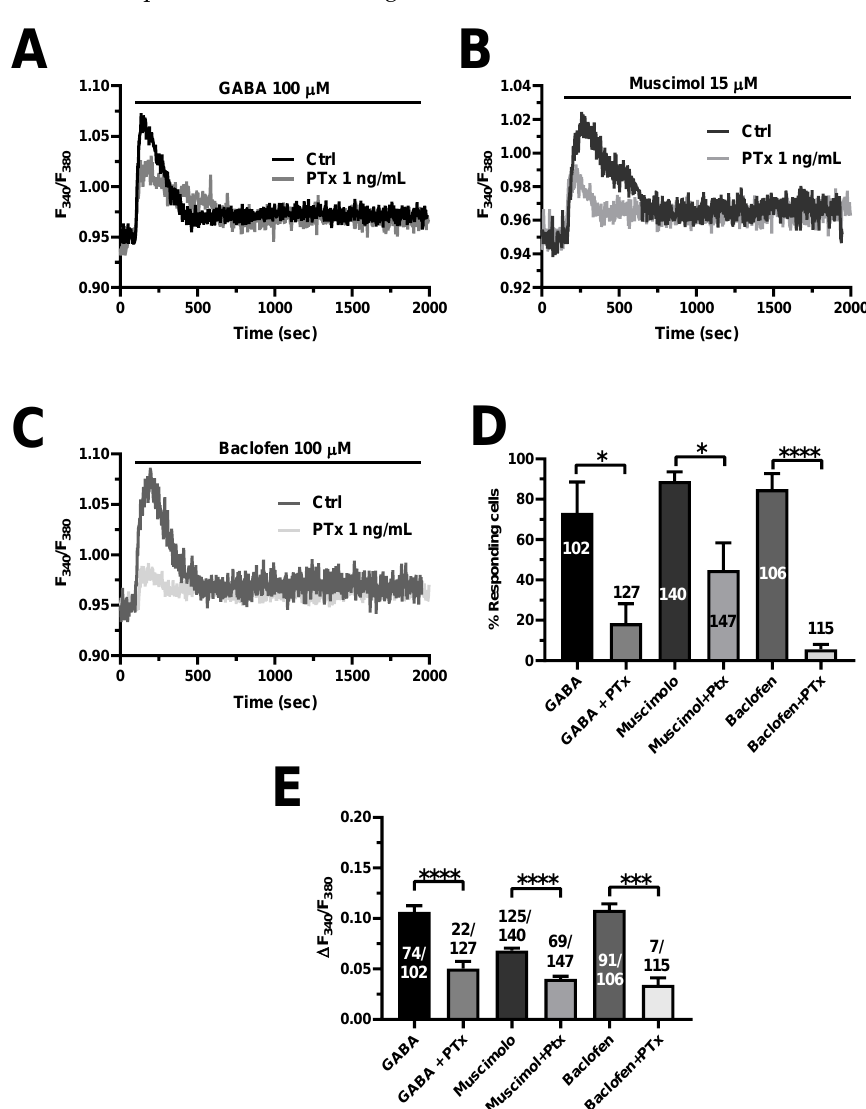
Figure 8. Selective inhibition of heterotrimeric G i/o proteins with pertussis toxin (PTX) reduces GABA A- and GABA B -induced intracellular Ca 2+ signals in hCMEC/D3 cells. ( A ), representative tracings of the biphasic Ca 2+ signals induced by GABA (100 µ M), in the presence and in the absence of PTx (1 ng/mL). ( B ), Representative traces of the Ca 2+ response induced by the GABA A receptor agonist, muscimol (15 µ M), in the presence and in the absence of PTx (1 ng/mL). ( C ), Representative Ca 2+ traces evoked by the GABA B receptor agonist, baclofen (100 µ M), in the presence and in the absence of PTx (1 ng/mL). ( D ), mean ± SE of the percentage of hCMEC/D3 cells responding under the designated treatments. **** indicate p < 0.0001, * indicates p < 0.05 (Student’s t -test). ( E ), mean ± SE of the amplitude of the peak Ca 2+ response under the designated treatments. **** indicate p < 0.0001, *** indicates p < 0.001 (Student’s t -test).